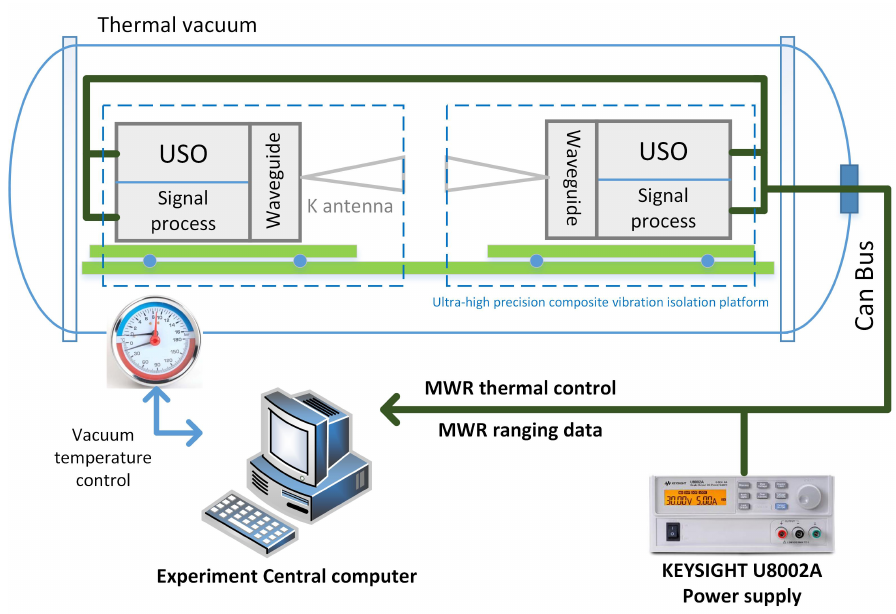
Figure 4. Schematic diagram of the MWR thermal control system in laboratory